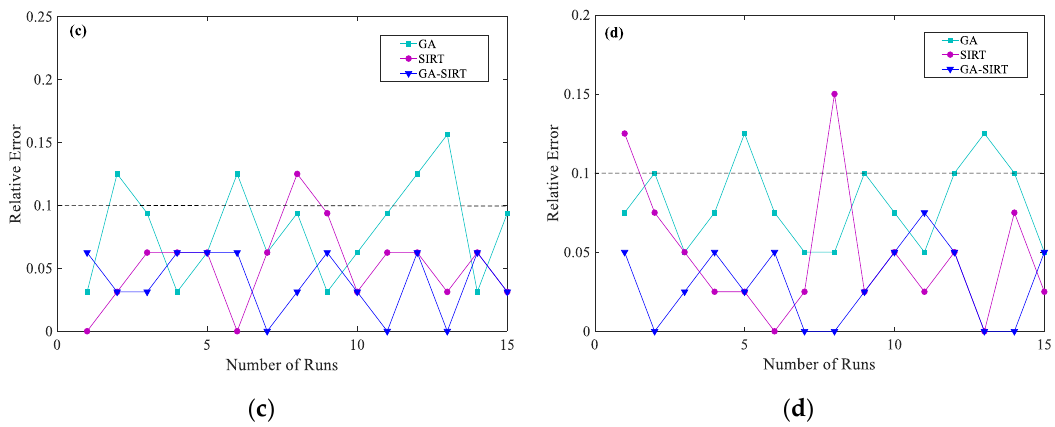
Figure 8. The relative error of coal thickness varied with the number of calculations in four samples when GA, SIRT, and GA-SIRT were applied. The samples had the following coal thickness values ( a ) 0.6 m, ( b ) 1.3 m, ( c ) 1.6 m, ( d ) 2.0 m.